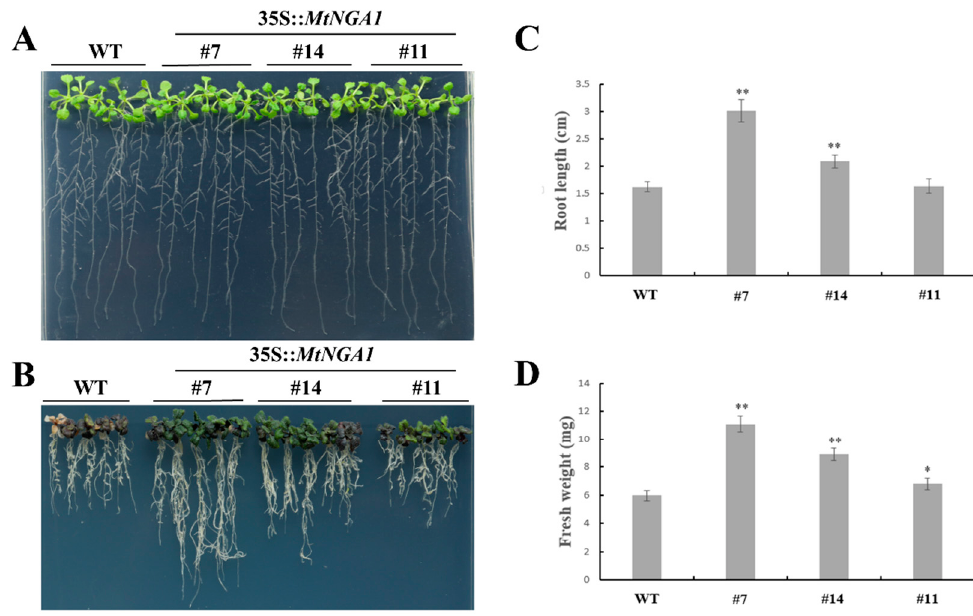
Figure 7. Phenotypic comparison of wild-type and transgenic plants under 500 mM mannitol treatment. ( A ) Five-day-old seedlings of three transgenic lines and WT plants were planted on 1 / 2 MS medium without mannitol and grown for 7 days. ( B ) Five-day-old seedlings of three transgenic lines and WT plants were planted on 1 / 2 MS medium with 500 mM mannitol and grown for 7 days. ( C ) The root lengths of plants in the transgenic lines and WT plants were measured 7 days after 500 mM mannitol treatment. ( D ) The fresh weights of plants in the transgenic lines and WT plants were measured 7 days after 500 mM mannitol treatment. The values are means ± SD ( n = 30). * indicates significant di ff erences of the means at p < 0.05 between transgenic lines and WT plants ( n = 30). ** indicates significant di ff erences of the means at p < 0.01 between transgenic lines and WT plants ( n = 30). For salt treatment, five-day-old seedlings were cultured on 1 / 2 MS medium containing 200 mM